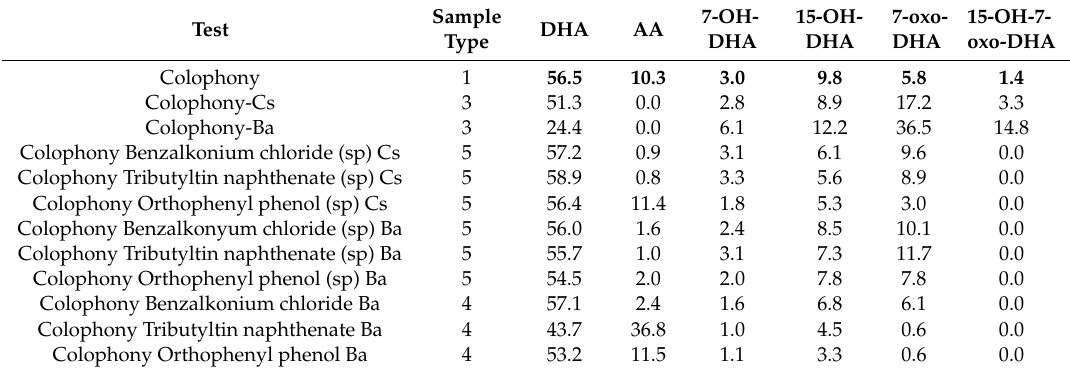
Table 2. GC-MS analysis ( p < 0.05 in all cases) of the diterpenes from the colophony varnish and the samples inoculated with microorganisms (values expressed in Ni